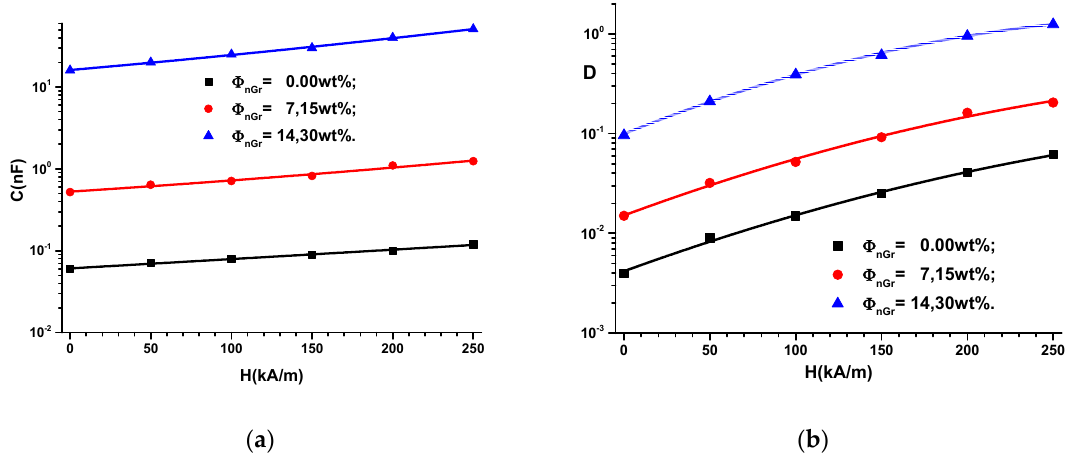
Figure 2. ( a ) The capacitance C of the FC; ( b ) the dielectric loss factor D dependence on the intensity